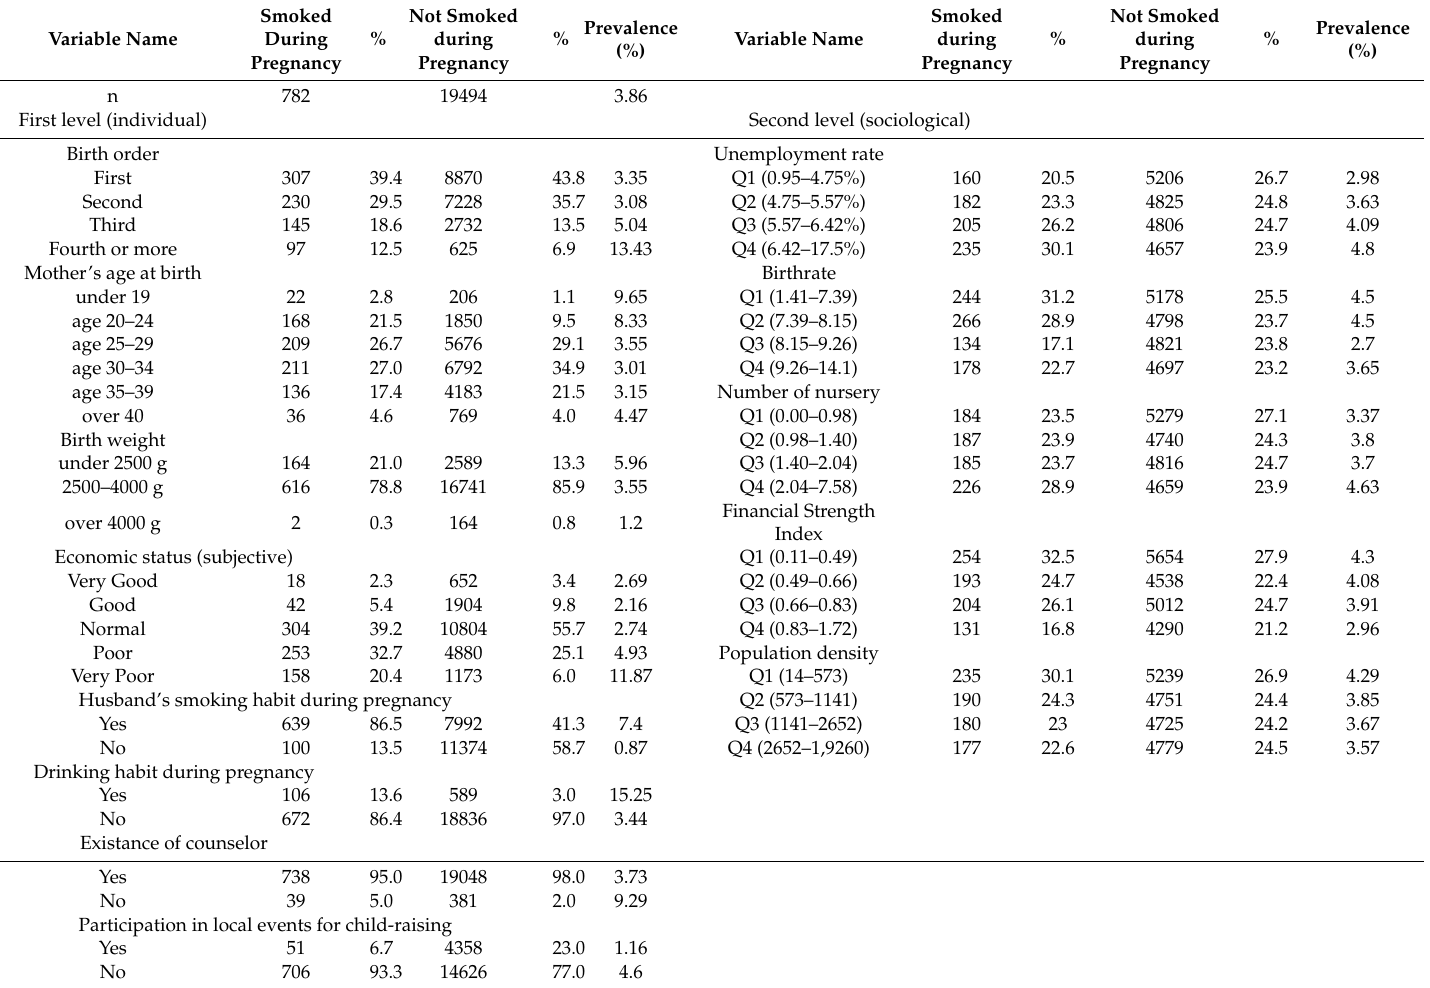
Table 2. Individual and regional